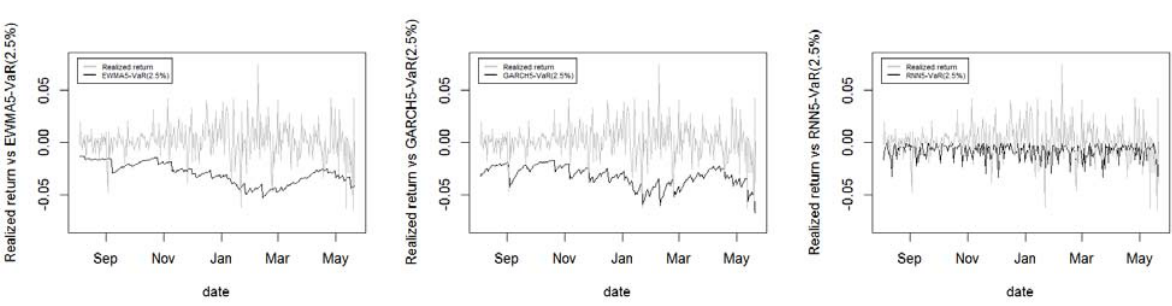
Figure A8. Out of sample realized return vs. 5 days ahead VaR (2.5%) of EWMA, GARCH and RNN model.